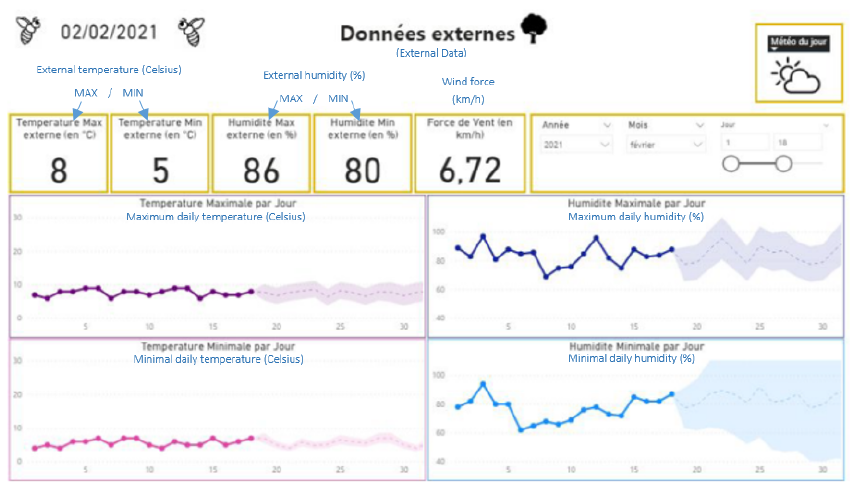
Figure 12. Dashboard: environmental data.